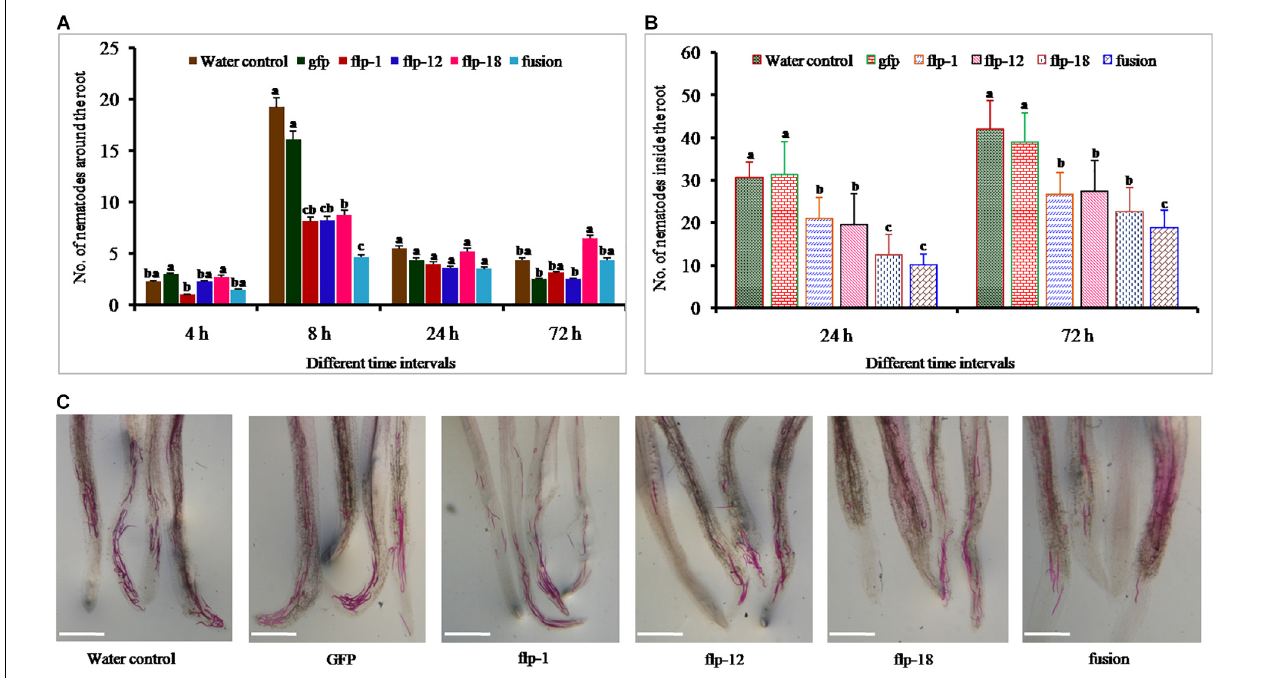
FIGURE 5 | (A) Penetration ability of Mi-flp1, Mi-flp12, Mi-flp18, and FLPs-fusion dsRNA-soaked M. incognita J2s in tomato roots on PF-127 medium at 4, 8, 24, and 72 h. Each bar represents the mean standard error ( n = 16); bars with letters stand for a significant difference at P > 0.05, (B) Number of nematodes inside tomato roots at 24 and 72 h of FLPs and GFP treated J2s and control worms in water, (C) Stained worms in infected tomato roots at 72 h post inoculation. Worms treated with non-native dsRNA (GFP) and worms in water were used as controls. Scale bar = 500 µ m. a , b , c Represents the values are statistical significant ( P = 0 . 001).